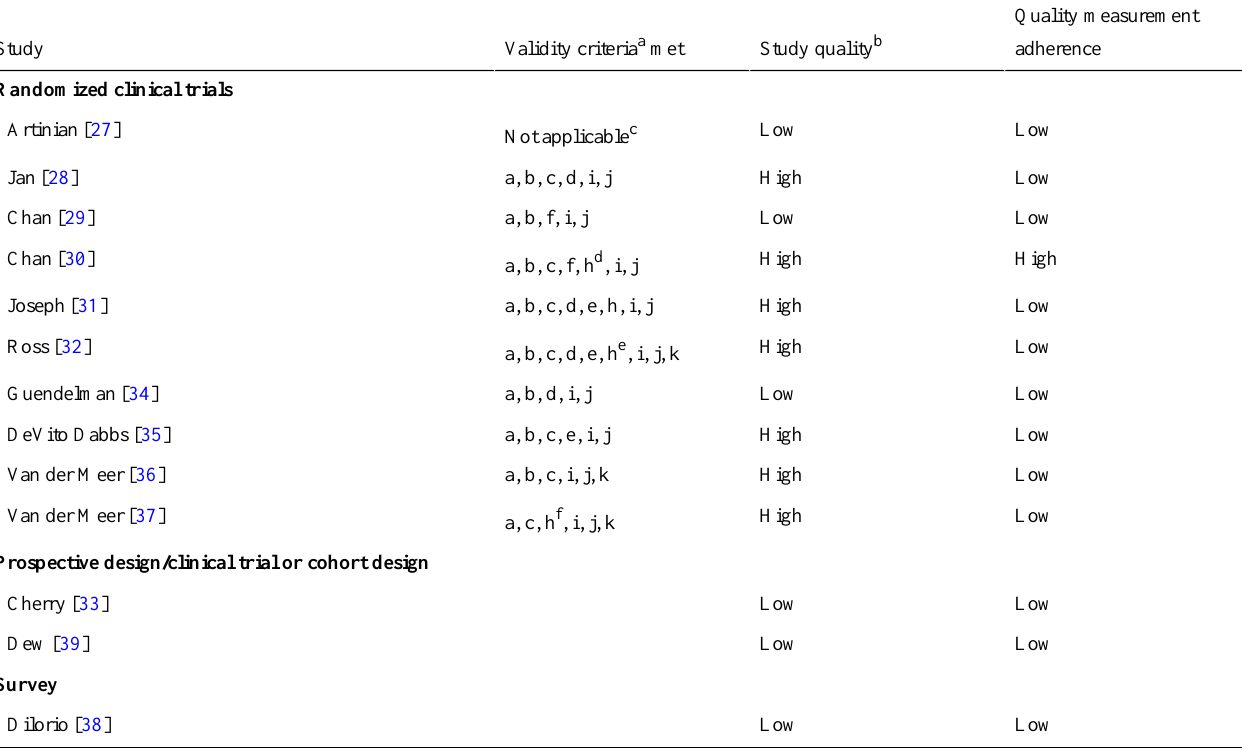
Table 3. Results of methodological